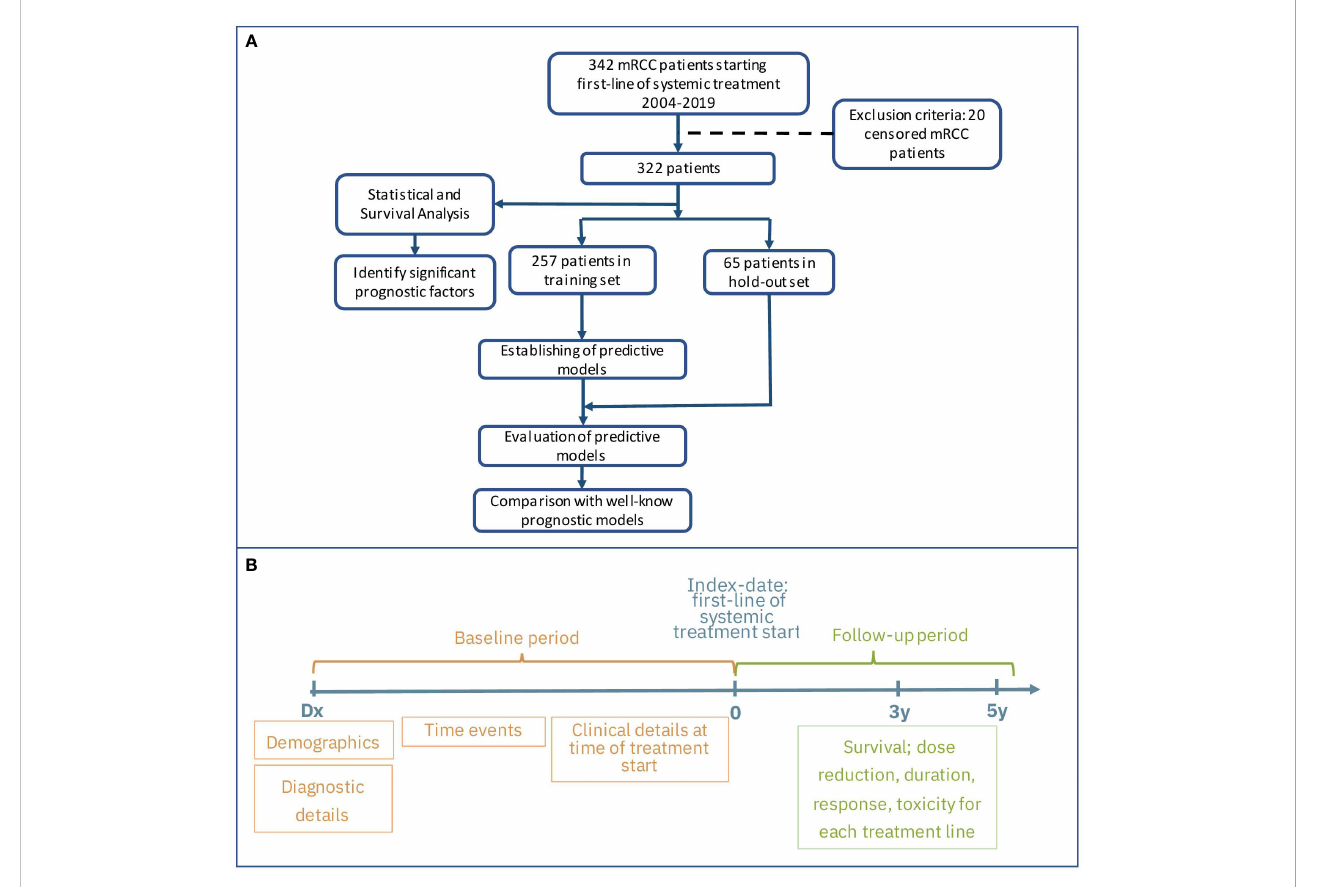
FIGURE 1 Flow chart of study design (A) and main groups of features and outcomes (B)